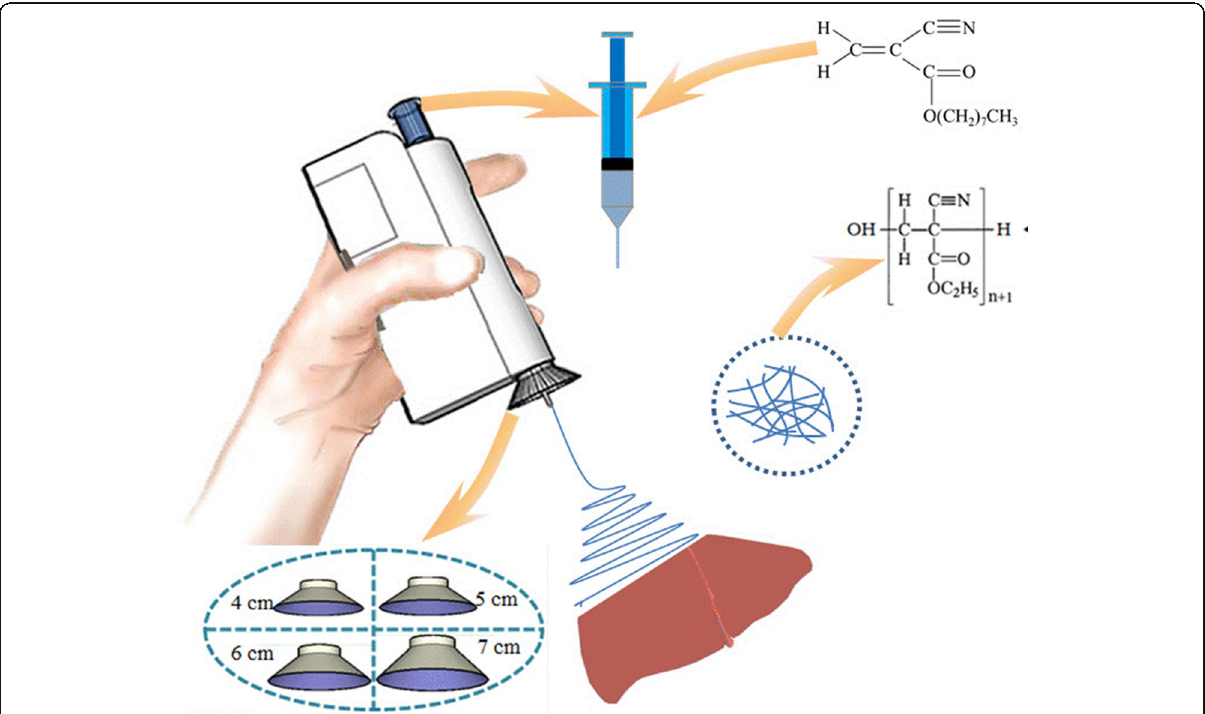
Fig. 1 Schematic diagram of the electric field-modified e-spinning NOCA fibers for liver resection